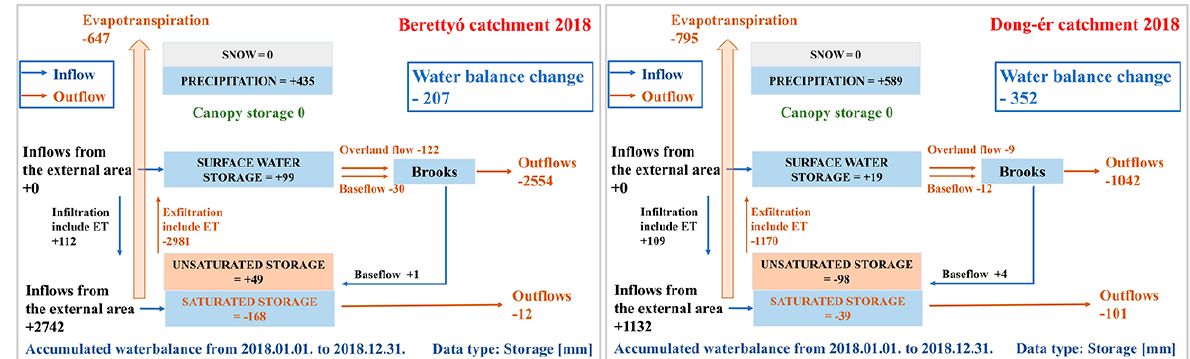
Figure 11. The water balance of the Berettyó and Dong-ér catchments in